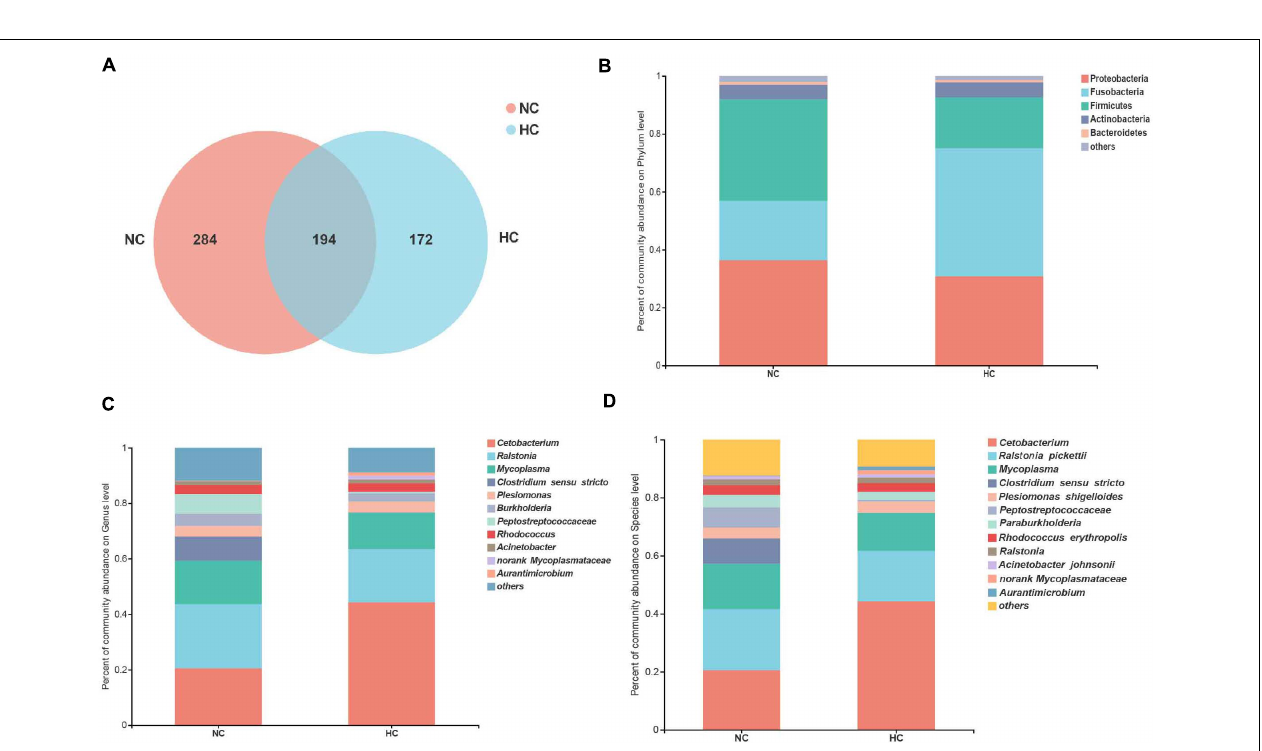
FIGURE 2 | Analysis of the composition of the intestinal microbiota of largemouth bass fed the NC and HC diets. (A) Venn diagram of unique and shared OTUs. (B–D) intestinal microbiota composition at the phylum, genus, and species levels, respectively (NC: 0% α -starch diet, HC: 22% α -starch diet).